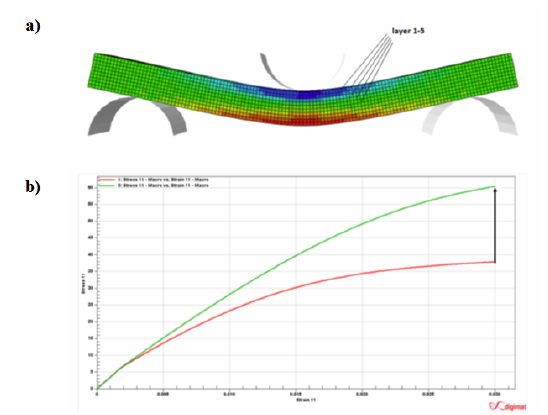
Figure 9. Adjustment of material behaviour un- der compression; a) illustration of layers for the ad- justment; b) red curve: stress-strain curve without adjustment, green curve: stress-strain curve with ad-